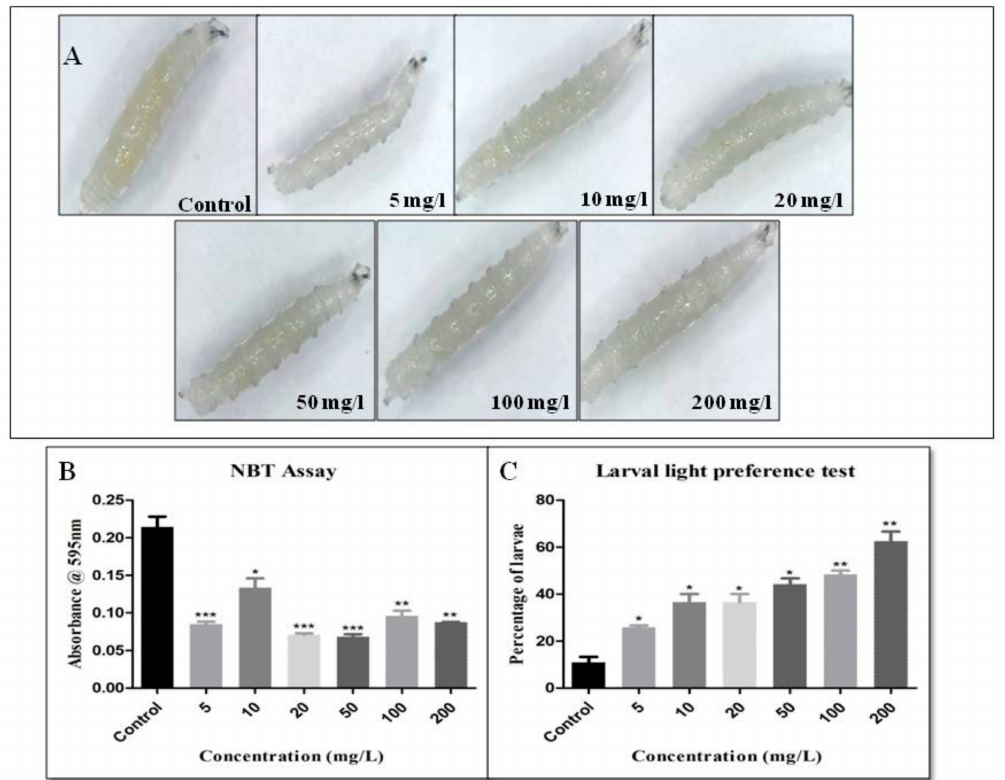
Figure 4. ( A ) Trypan blue assay of the larva to check cell damage in the gut. ( B ) NBT assay to determine the level of ROS in the larva at various concentrations of Wood-based Cellulose Nanofibrils (CNF) ( C ) Larval light avoidance behaviour to assess the percentage of larva in the light and dark region (* for p -value < 0.05, ** for p -value < 0.001, *** for p -value <